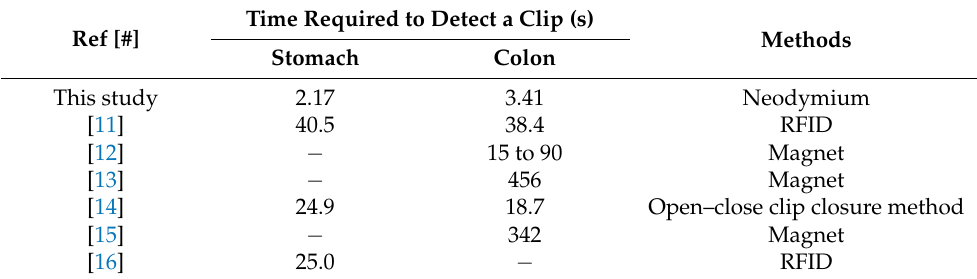
Table 1. Comparison of the time required to locate a clip using the designed clip–detector and using other methods reported in the